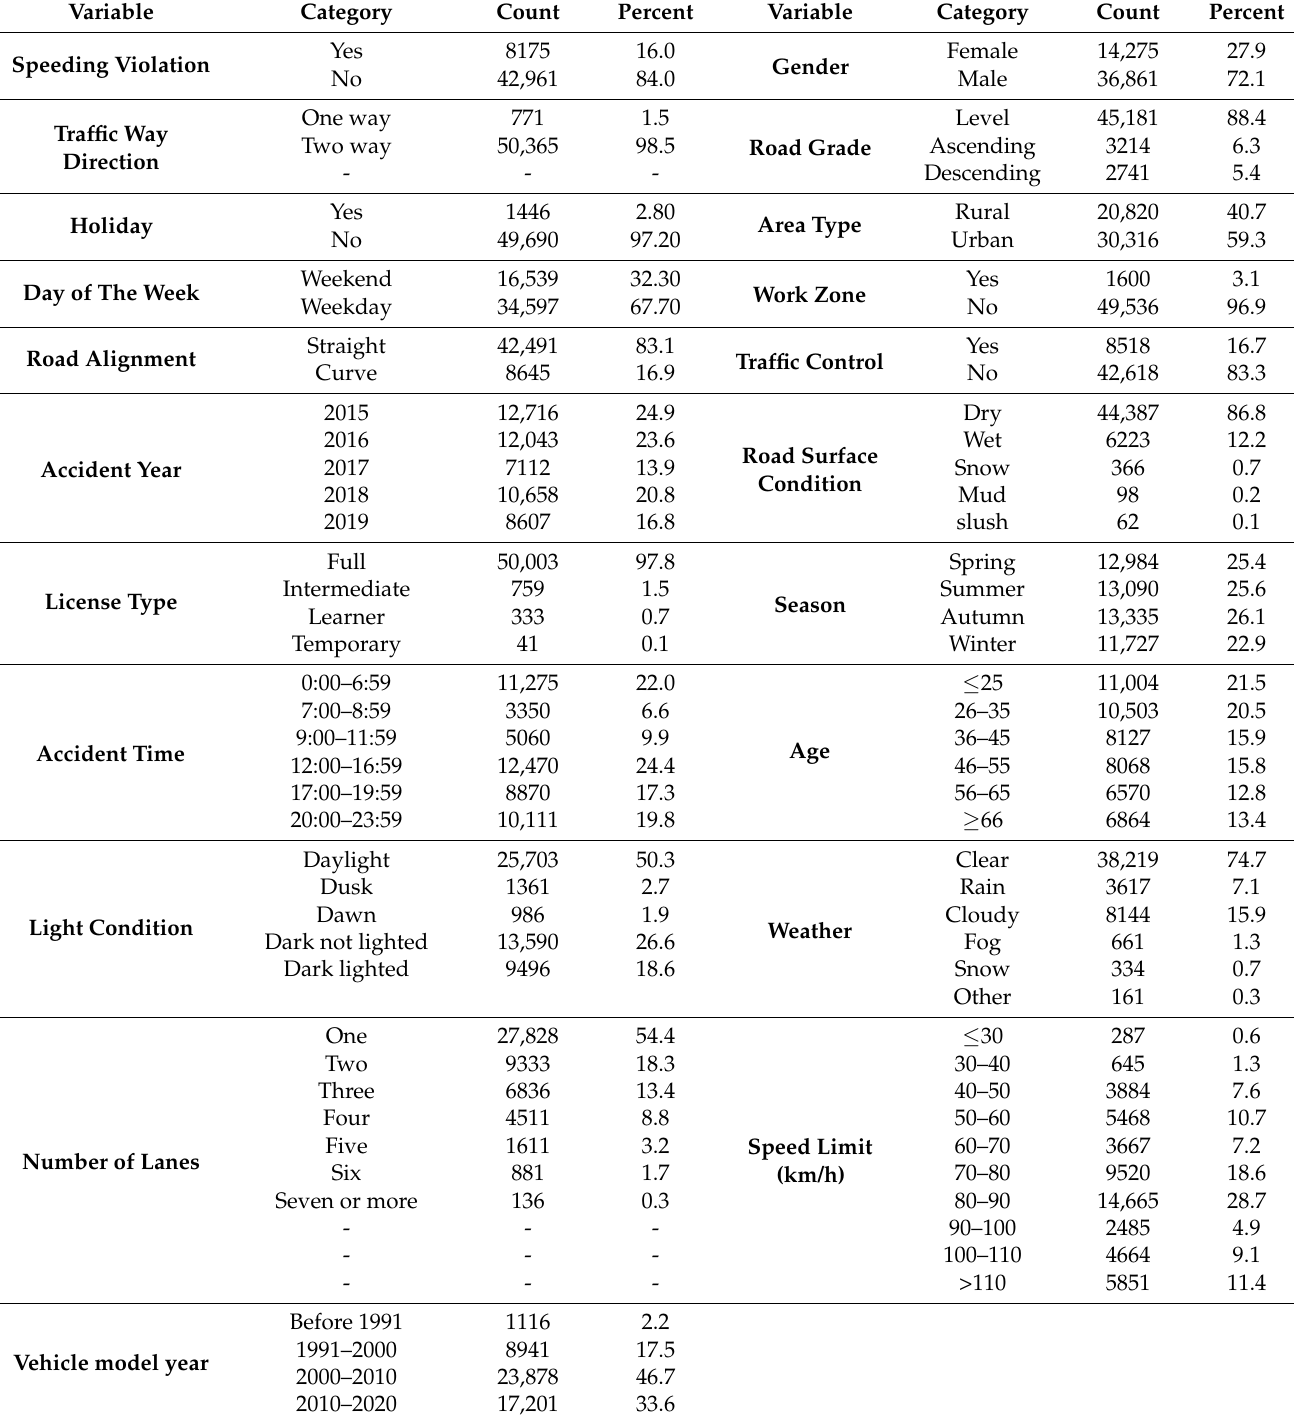
Table 1. Variables Description for the Studied